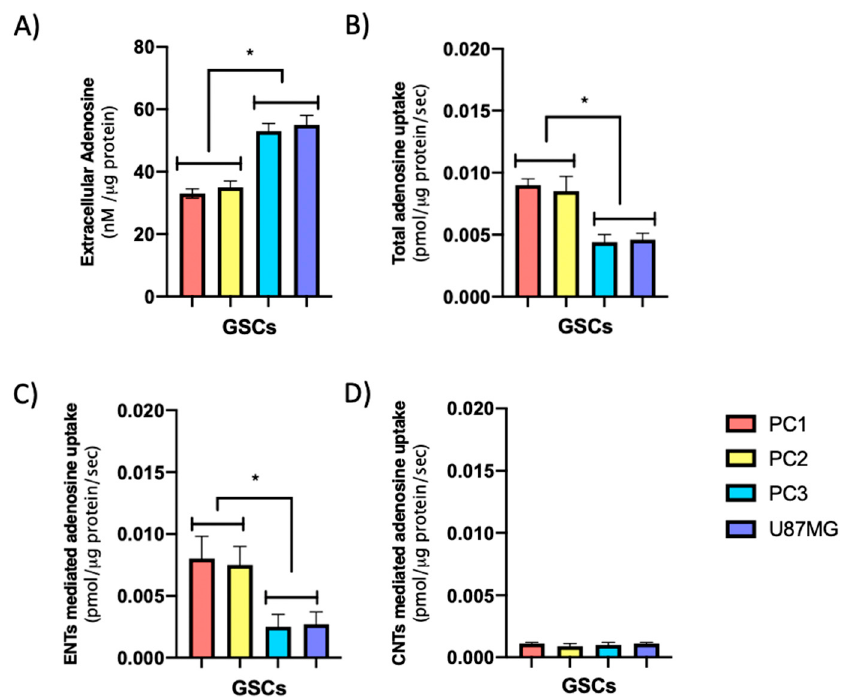
Figure 3. Adenosine uptake activity in proneural (PN) and mesenchymal (MES) GSCs. PN GSCs (PC1 and PC2) and MES GSCs (PC3 and U87MG) were previously characterized (Supplementary Figure S1). ( A ) Extracellular adenosine levels (nM) in GSC subtypes were quantified as described in Methods 2.4. ( B ) Total adenosine uptake mediated by concentrative (CNTs) and equilibrative (ENTs) systems were obtained in a transport bu ff er containing Na + . ( C ) ENTs adenosine mediated uptake was determined by using a Na + free bu ff er. ( D ) CNTs component was derived from the di ff erence between total transport activity in the Na + containing bu ff er minus the transport activity in the Na + free bu ff er. The plots represent the means ± S.D. *, p < 0.05. n =